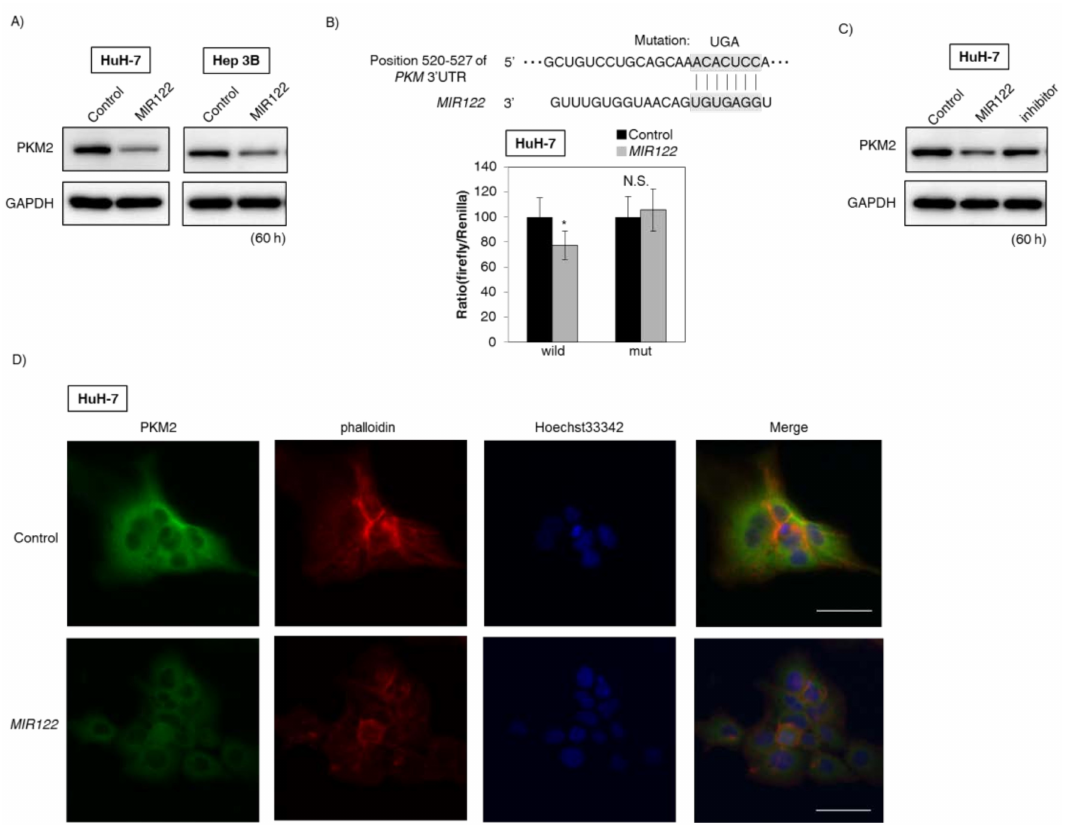
Figure 3. MIR122 negatively regulated PKM expression through the direct targeting of PKM mRNA. ( A ) Protein expression levels of PKM2 at 60 h after the transfection of hepatocellular carcinoma (HCC) cell lines (HuH-7 and Hep 3B) with MIR122 (20 nM); ( B ) Luciferase activities after co-transfection with control or MIR122 and wild-type or mutant-type pMIR vectors having the predicted MIR122 binding site in the 3 (cid:48) -UTR of PKM . The upper panel shows the region of the 3 (cid:48) UTR of human PKM mRNA complementary to the mature MIR122 . The box indicates the predicted binding sites for MIR122 . Effects were assessed at 24 h after the transfection (20 nM); ( C ) Protein expression levels of PKM2 in HuH-7 cells after combined treatment with antago MIR122 / MIR122 . Control lane: treatment with control miRNA (20 nM). MIR122 lane: treatment with MIR122 (20 nM). Inhibitor lane: treatment with MIR122 (10 nM) + antago MIR122 (10 nM). Effects were assessed at 60 h after the transfection; ( D ) Immunofluorescence of PKM2 at 60 h after transfection of HuH-7 cells with MIR122 (20 nM). Upper panel, treatment with control miRNA; Lower panel, treatment with MIR122 . PKM2 is dyed green; cell membrane, red; and nuclei, blue. Representative photographs from two experiments are shown. Scale bar = 50 µ m. Results are presented as the mean ± SD; * p < 0.05; N.S., not statistically